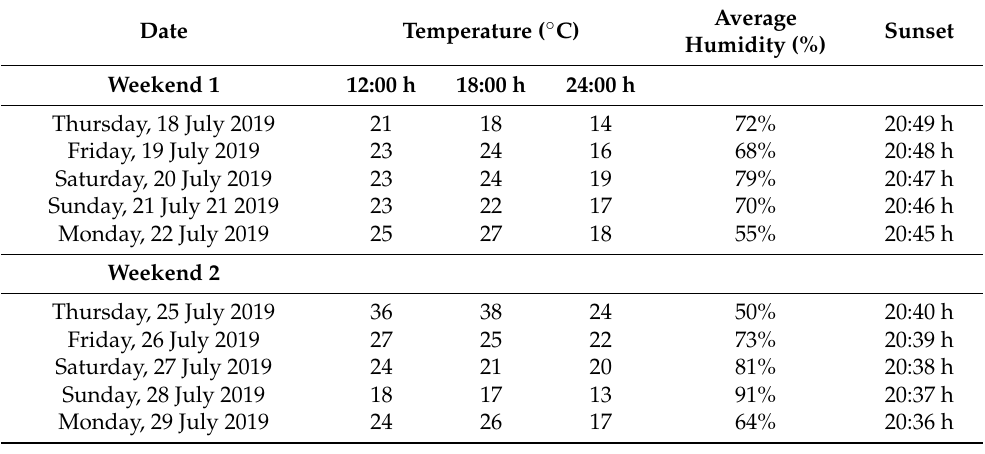
Table 2. Meteorological data on both MG weekends.